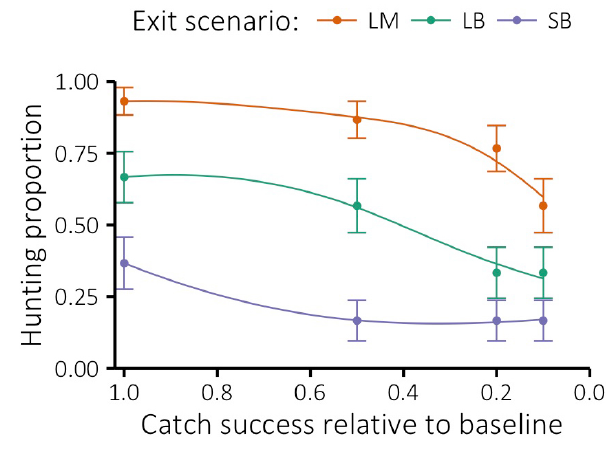
Fig. 4 . The proportion of respondents who would continue to hunt in different scenarios of catch success. The first point for each group of game corresponds to the baseline level of catch for each group on a typical hunting trip; the other points correspond to 50%, 20%, and 10% of the baseline catch success. Hunters were prompted to imagine that they could only hunt large mammals (LM), large birds (LB), or small birds (SB) within each set of scenarios. A LOESS curve (span = 1.15) was fit for the proportion of hunters who would continue hunting for each category of game (LM, LB, and